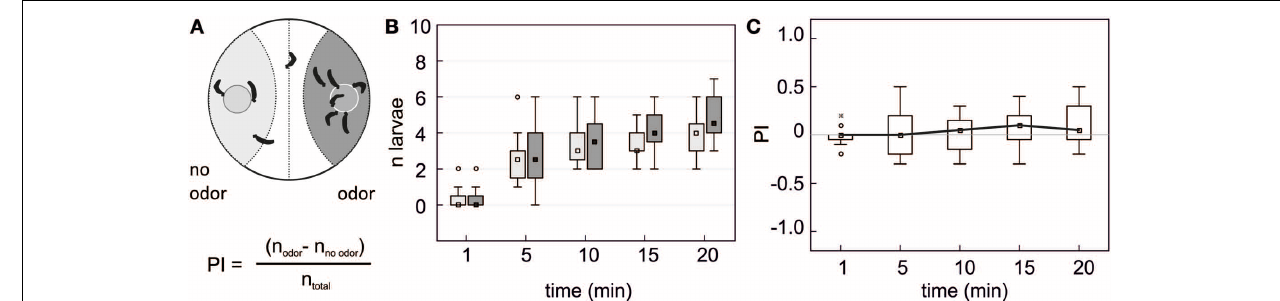
FIGURE 1 | Binary choices behavioral assay. (A) Schematic diagram of the experimental arena. Two food pellets with added odor ant (odor) or with mineral oil only (no odor) are disposed in a Petri dish and 10 caterpillars are gently deposited on the midline of the bottom of the Petri dish at the beginning of the experiment. We recorded their position every five min and counted the number of larvae located within the control zone, the middle zone or the test zone. A preference index (PI) was computed to express the ratio of larvae on each side. (B) Box-and-whisker plots of the position of the larvae on each side of the arena (light gray rectangles = “no odor” side and dark gray = “odor” side) across time in the absence of any odor (control experiment) ( n = 10). The boundaries of the box plots represent the first and third quartiles, and the squares represent the median value. The range of